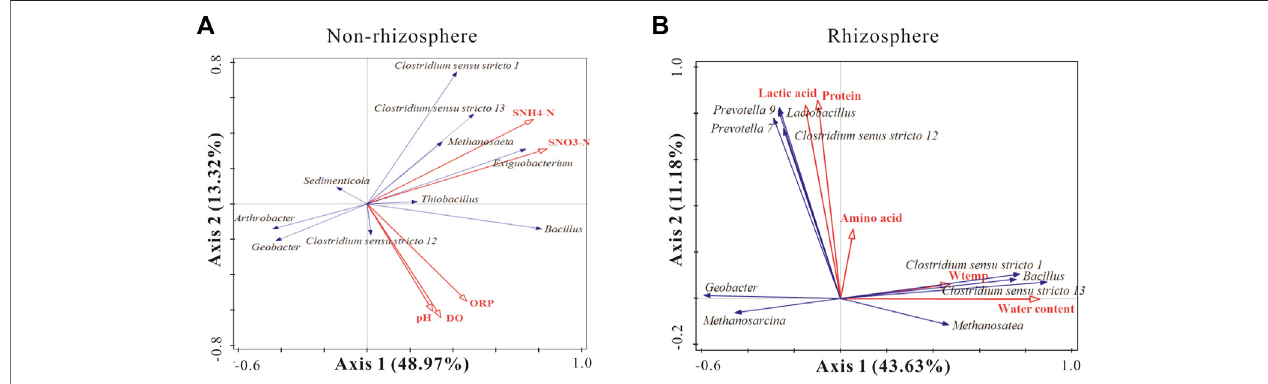
FIGURE7| RDAanalysisofspeciescompositionofsedimentbacterialtaxaassociatedwithsigni fi cantenvironmentalfactors. Theblueandredarrowsindicatetop 10 functional bacteria genus and signi fi cant environmental factors in the non-rhizosphere sediments (A) and the rhizosphere sediments (B) .